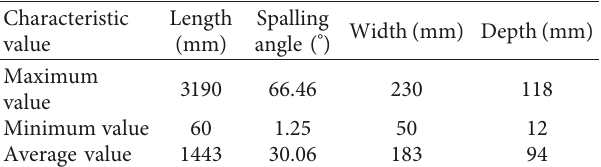
Figure 4: Distribution of spallings in the circumferential region along segment ring. Table 1: Statistical results of the length, width, and depth of